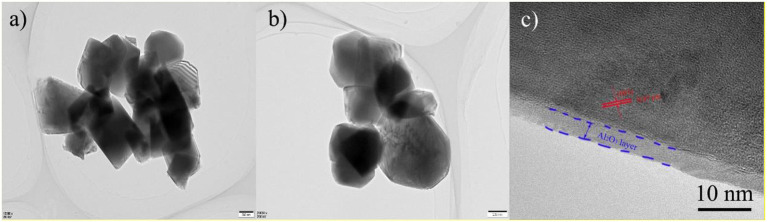
TEM image of (a) LNCM and (b) PLA-1-Al2O3@LNCM, (c) HR-TEM image PLA-1-Al2O3@LNCM.